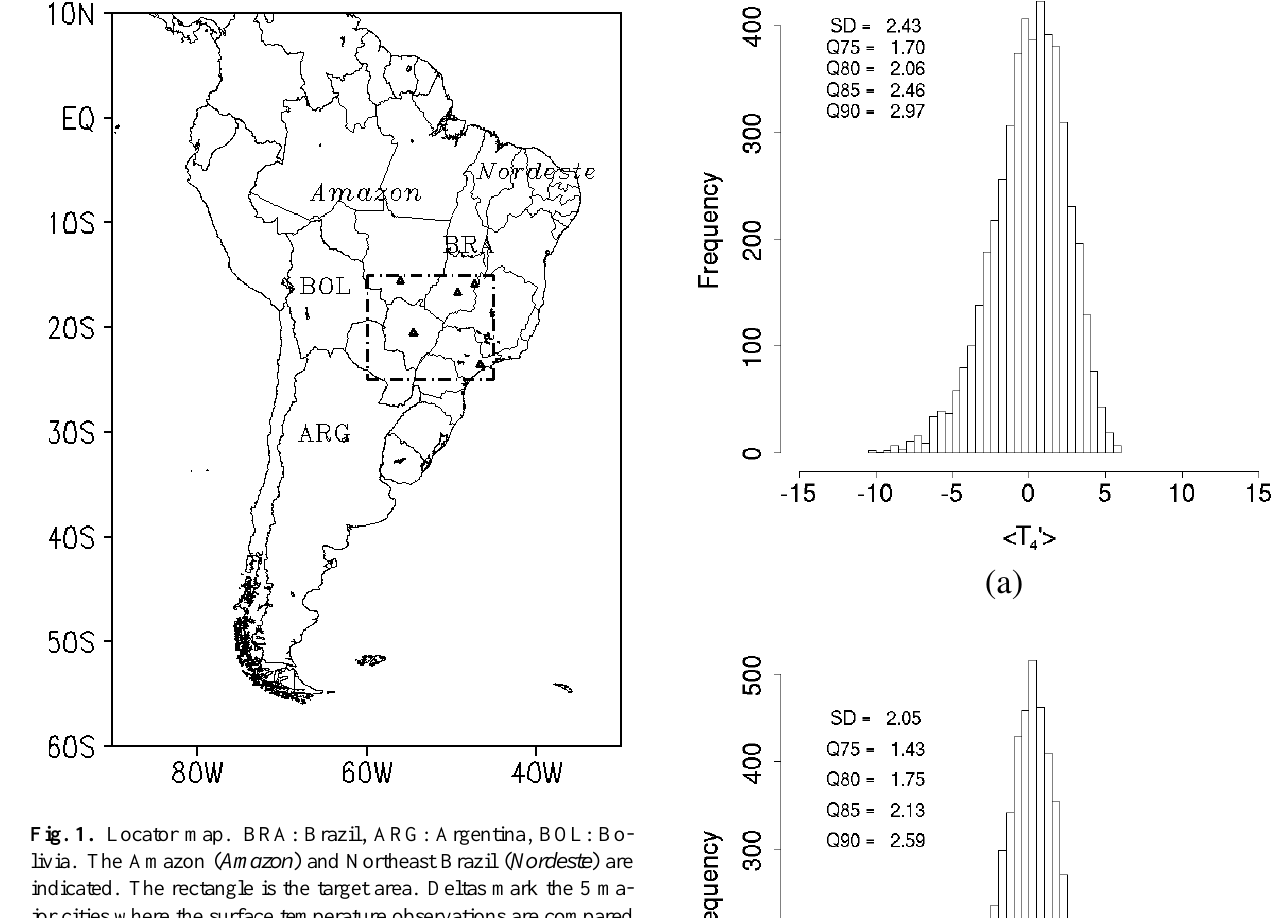
month of the year. For a given month T c is obtained by av- eraging the 00:00 UTC surface temperature over the same 40 calendar months in the period 1961 through 2000. The anomaly T 0 is given by T − T c . T 0 is a function of day only (not a function of grid point) and is the daily 00:00